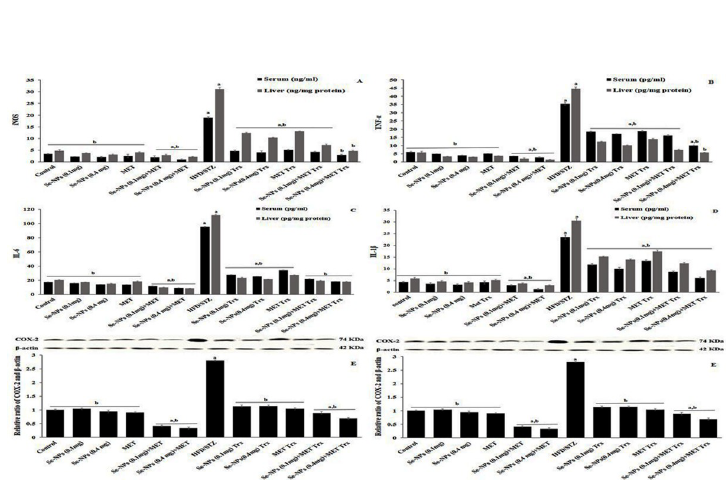
Fig 6. A graphical presentation of serum and hepatic inflammatory mediators in HFD/STZ-induced rats treated with Se-NPs, MET monotherapy, and combined therapy. Levels of inflammatory cytokines, including iNOS (A), TNF- α (B), IL-6 (C) and IL-1 β (D), were measured in serum and liver tissues by ELISA (n = 5). Protein expression levels of COX-2 (E) and p-p65 (F), were measured in liver tissues by western blot, β -Actin was used as a loading control. Values are expressed as mean ± SE (the mean of three assays for western blot). Significant changes (p < 0.01) with respect to control and HFD/STZ-experimental rats are expressed by the letters (a) and (b),